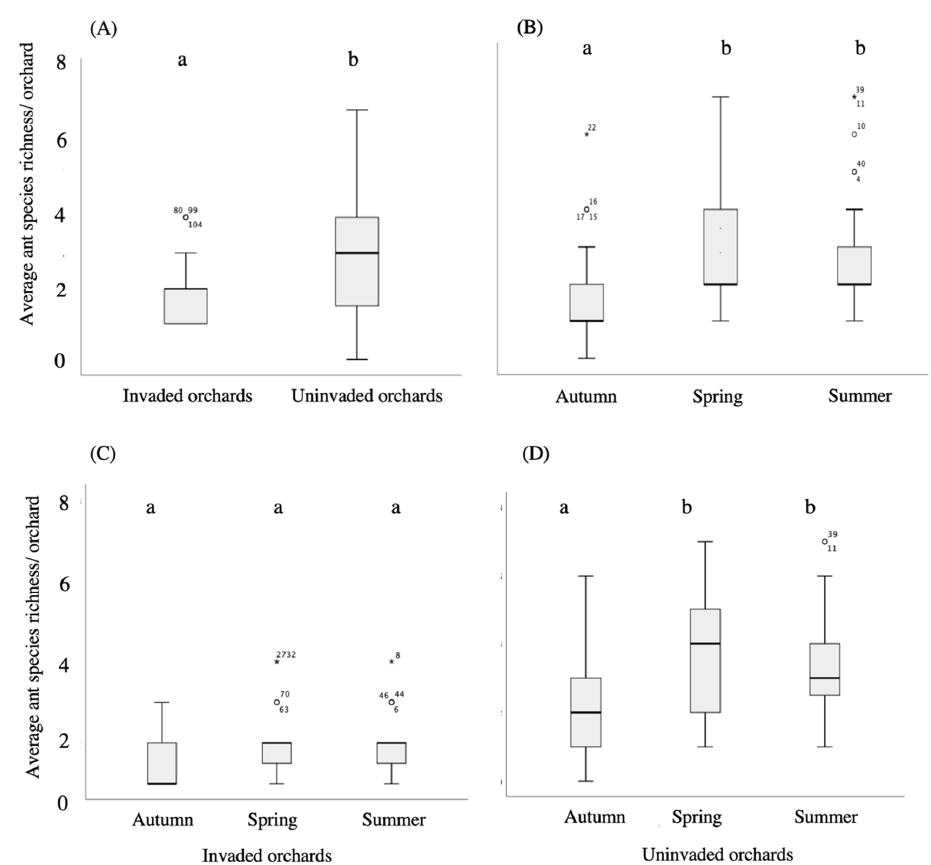
Figure 3. Box plots representing the average ant species’ richness per orchard in function of the invasion of the Argentine ant ( A ) and the season ( B ) in invaded ( C ) and uninvaded ( D ) citrus orchards. Boxes show interquartile ranges (25th and 75th percentiles), middle lines are medians, whiskers are non-outlier ranges beyond the boxes, circles are the outliers and asterisks are the extreme outliers. Different letters show significant differences between invasion treatment groups and among seasons by the fitted generalized linear mixed model (GLMM).